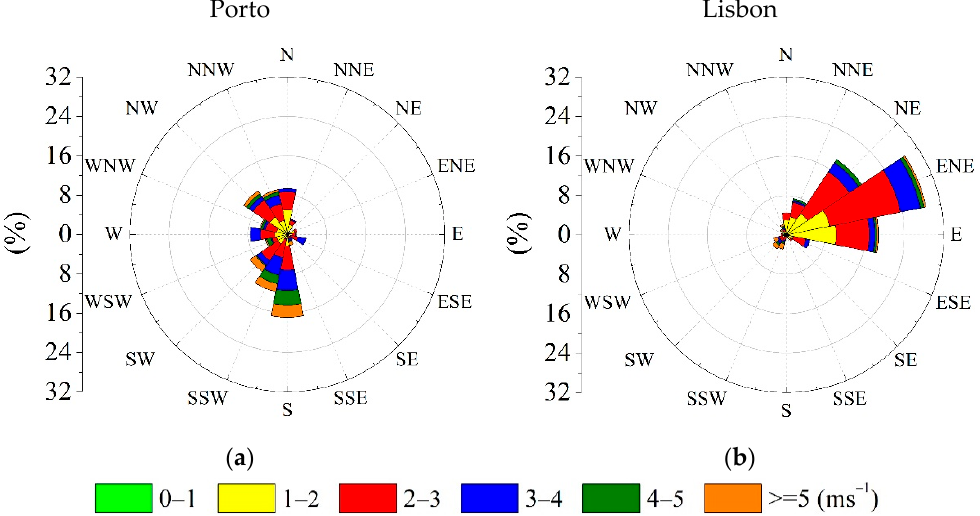
Figure 9. Joint relative frequency of wind direction and wind speed associated to the fog events at Porto ( a ) and Lisbon ( b ).